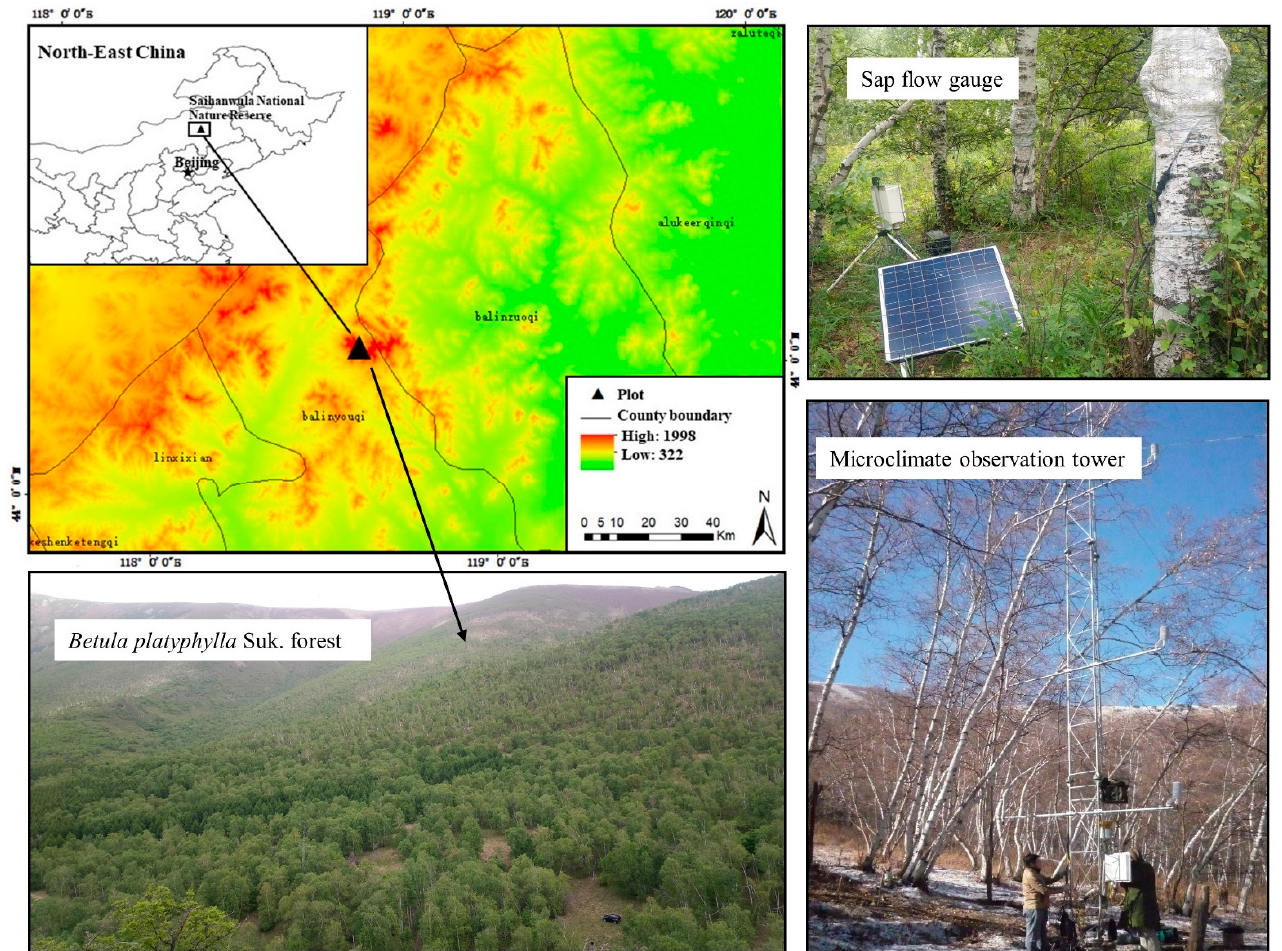
Figure 1. Location of the study area in Northeast China, and the pictures of the Betula platyphylla Sukaczev Forest; equipment for measuring sap flow and the weather